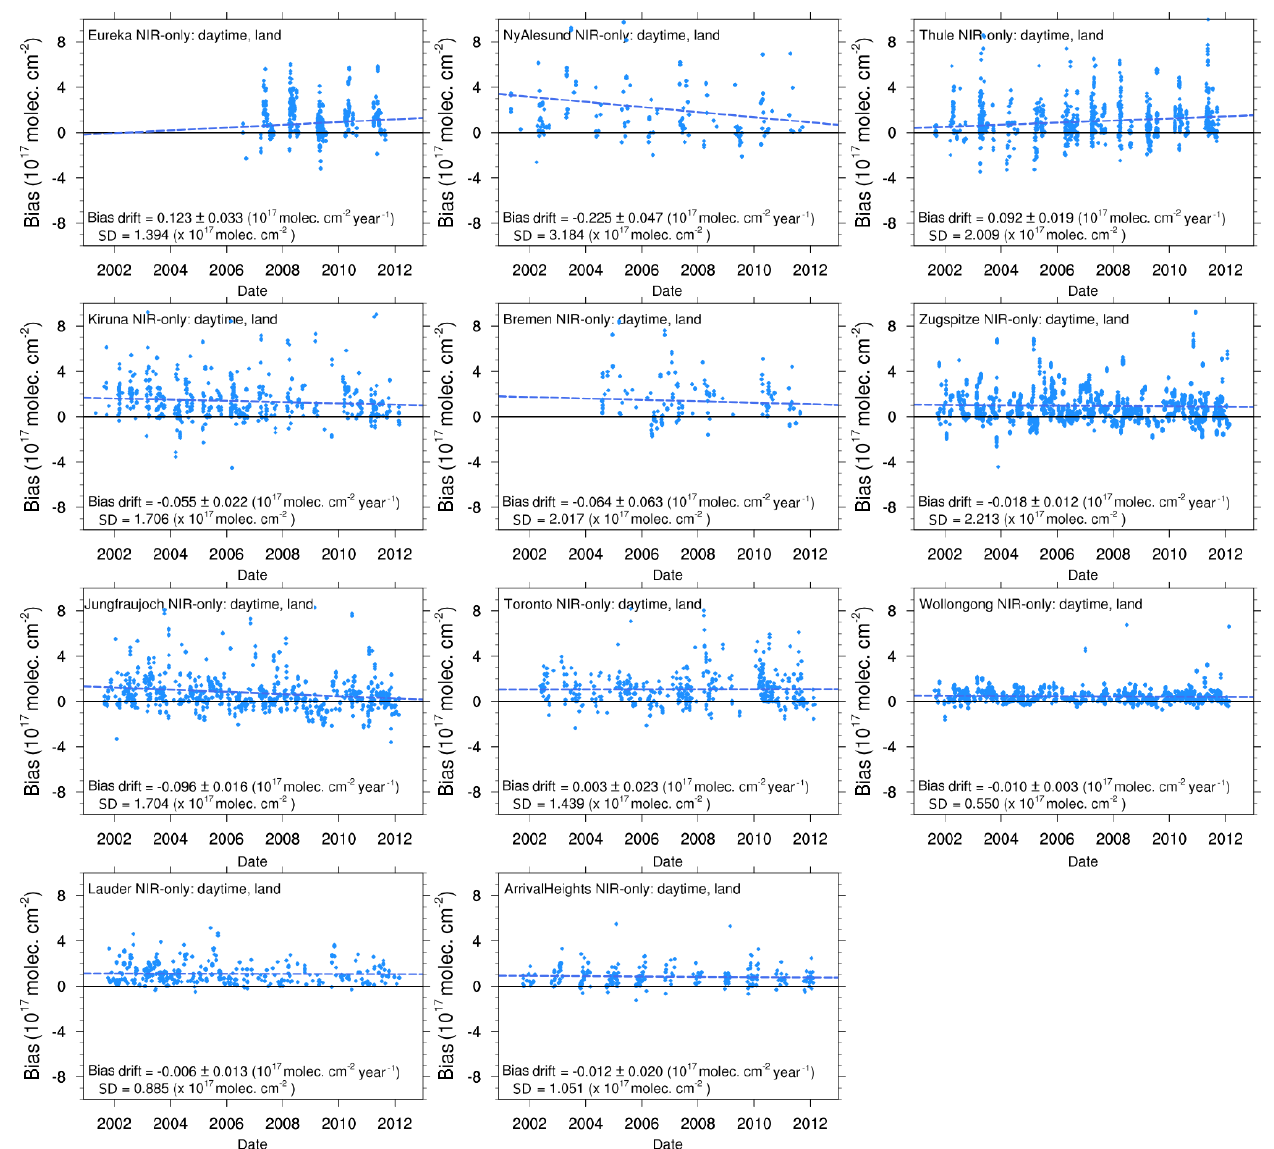
Figure A6. Temporal evolution of bias (MOPITT–FTS) at all stations for V6 NIR-only product. The blue dashed line indicates bias